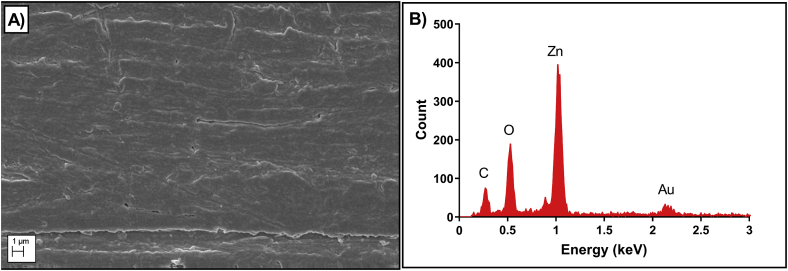
A) SEM image of the uniform deposition of ZnO thin film on the sensor platform. (B) EDAX spectra of the sensing platform representing chemical composition for the region represented in the SEM image.